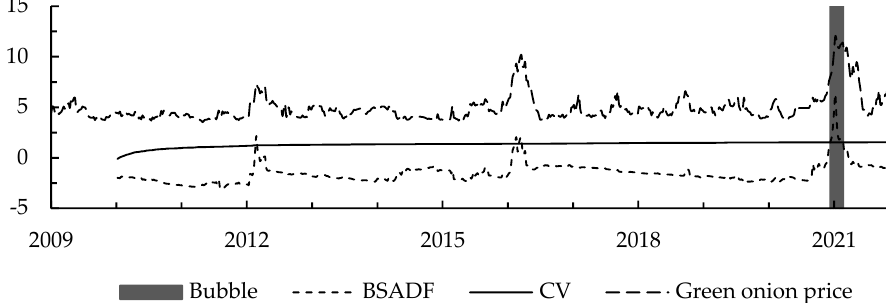
Figure 3. Bubbles in green onion prices.